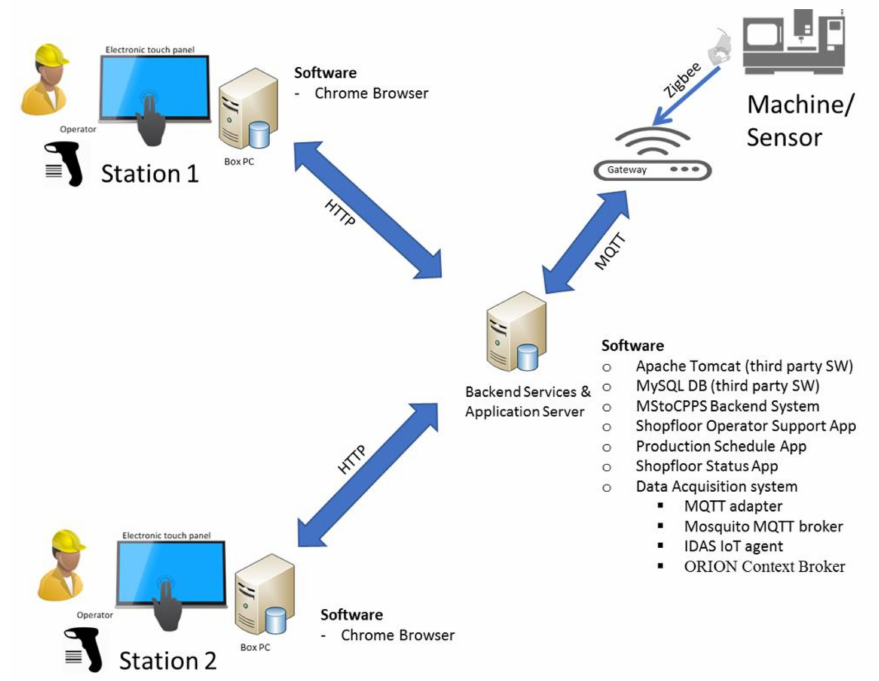
Figure 6. Solution deployment on the shop-floor.